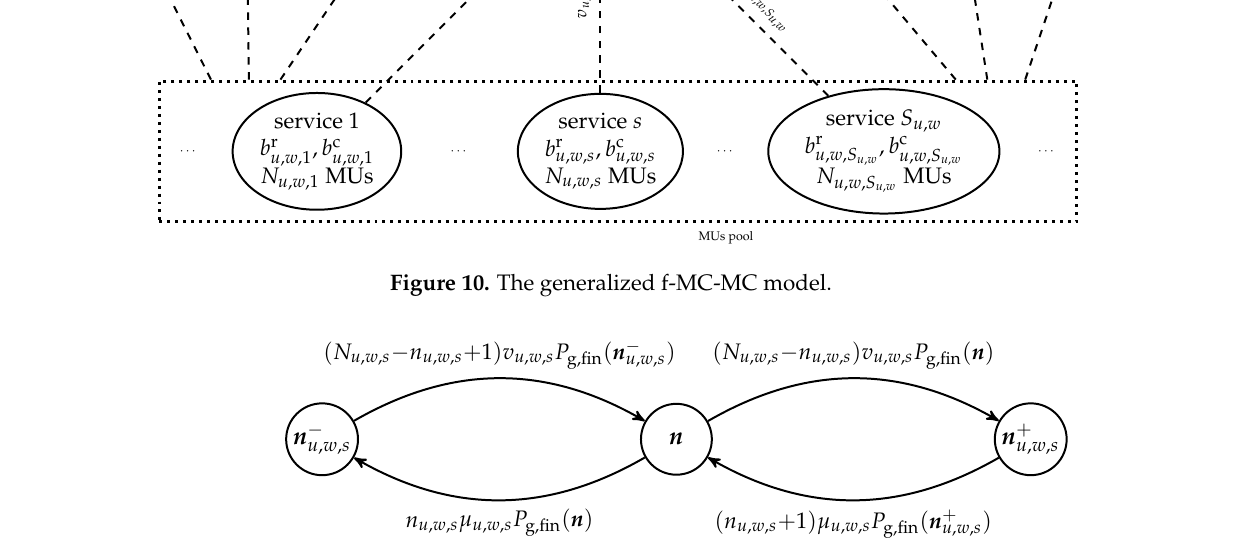
Figure 11. Transition diagram for calls of service class s in the u , w -th